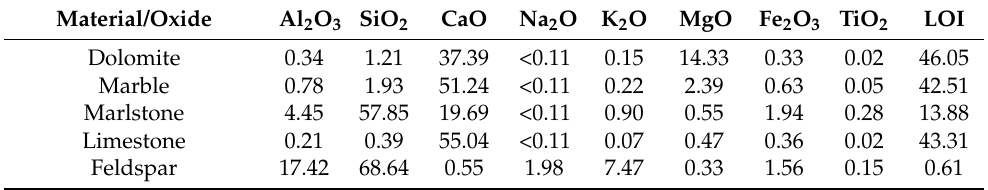
Table 2. Chemical analyses of the various types of waste stone powder (the main oxides in wt. %).